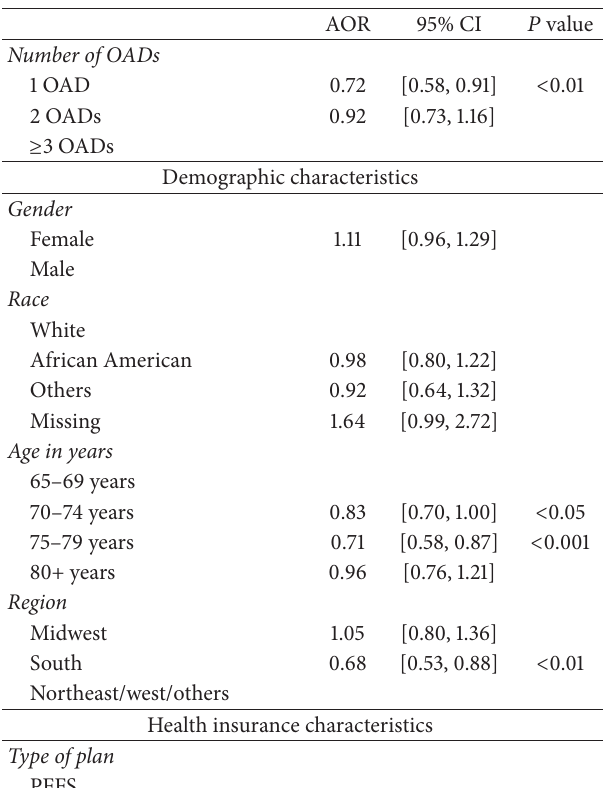
Table 3: Adjusted odds ratios and 95% confidence intervals from logistic regressions of multiple versus single rapid acting insulin prescriptions during 12-month follow-up among elderly ( ≥ 65 years) Medicare beneficiaries with type 2 diabetes mellitus who added rapid acting insulin to their oral antidiabetic drug. Humana